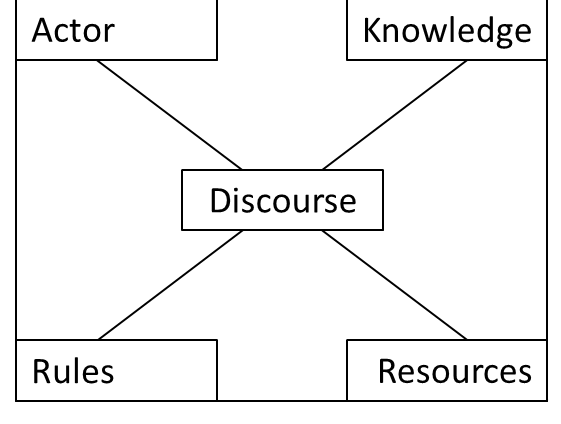
Fig. 1 . Knowledge in the policy arrangements framework, adopted and adapted from Arts et al.